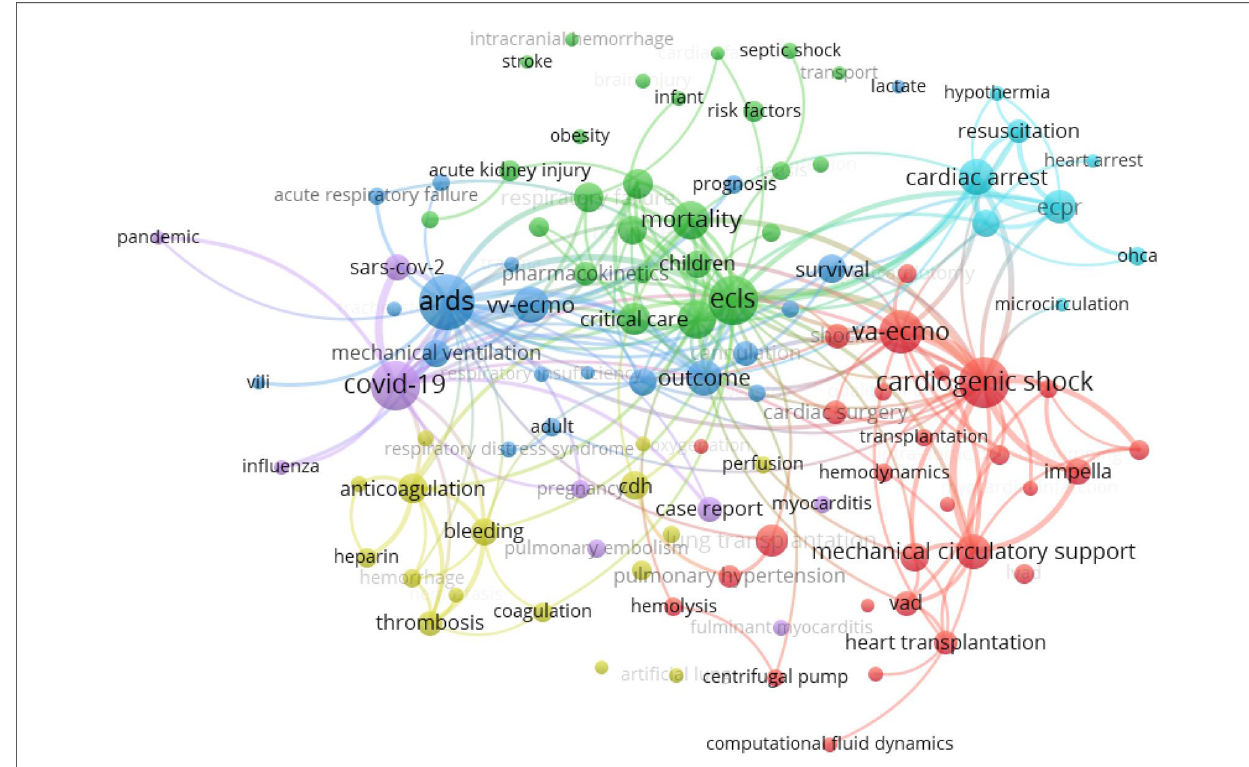
FIGURE 6 Keyword co-occurrence mapping of ECMO research papers, 2018 –